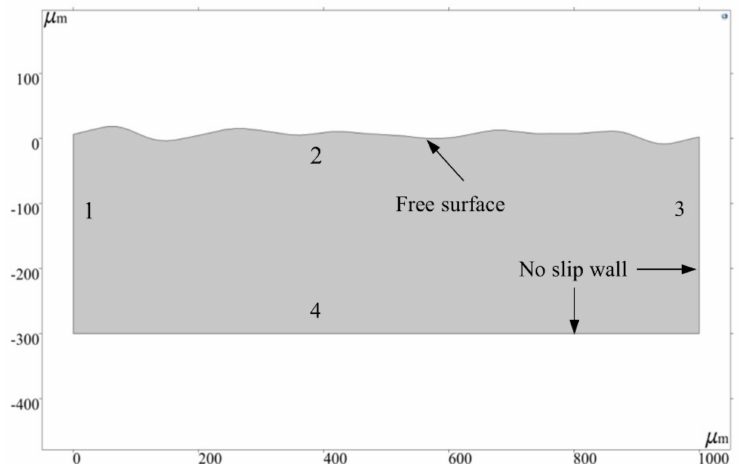
Figure 8. Model geometry.